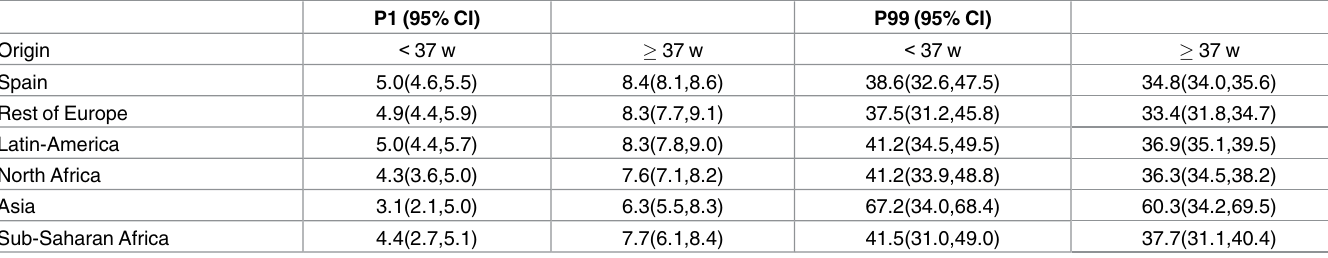
Table 2. Atypical hemoglobin A values (%) according to maternal origin and gestational age for female